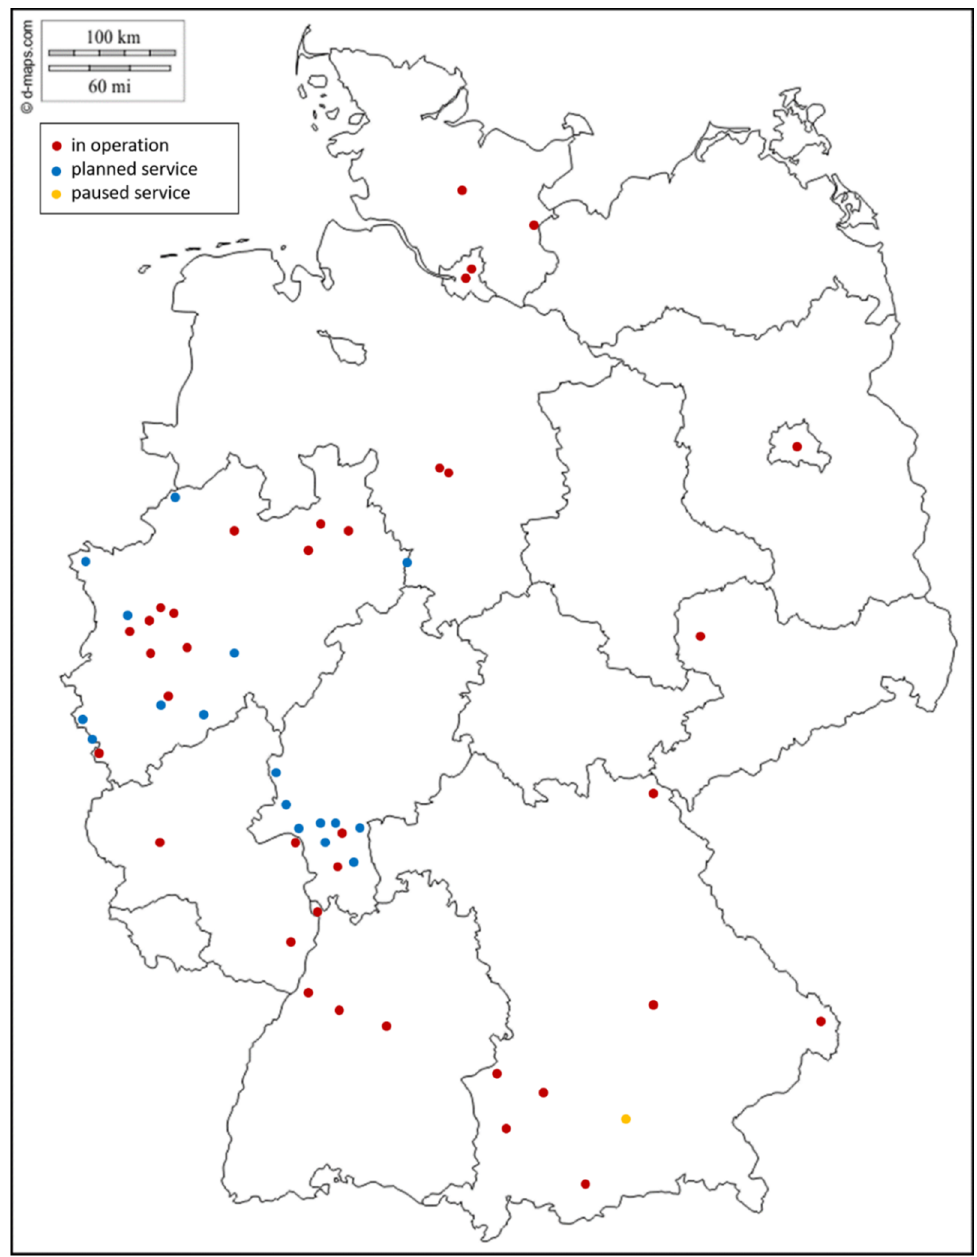
Figure 1. New mobility offers vary significantly from state to state. This map shows Germany with its 16 federal states. The data set was collected in May 2021. The red dots show the current mobility services. The yellow locations are currently suspended, while the areas marked in blue will be starting soon.